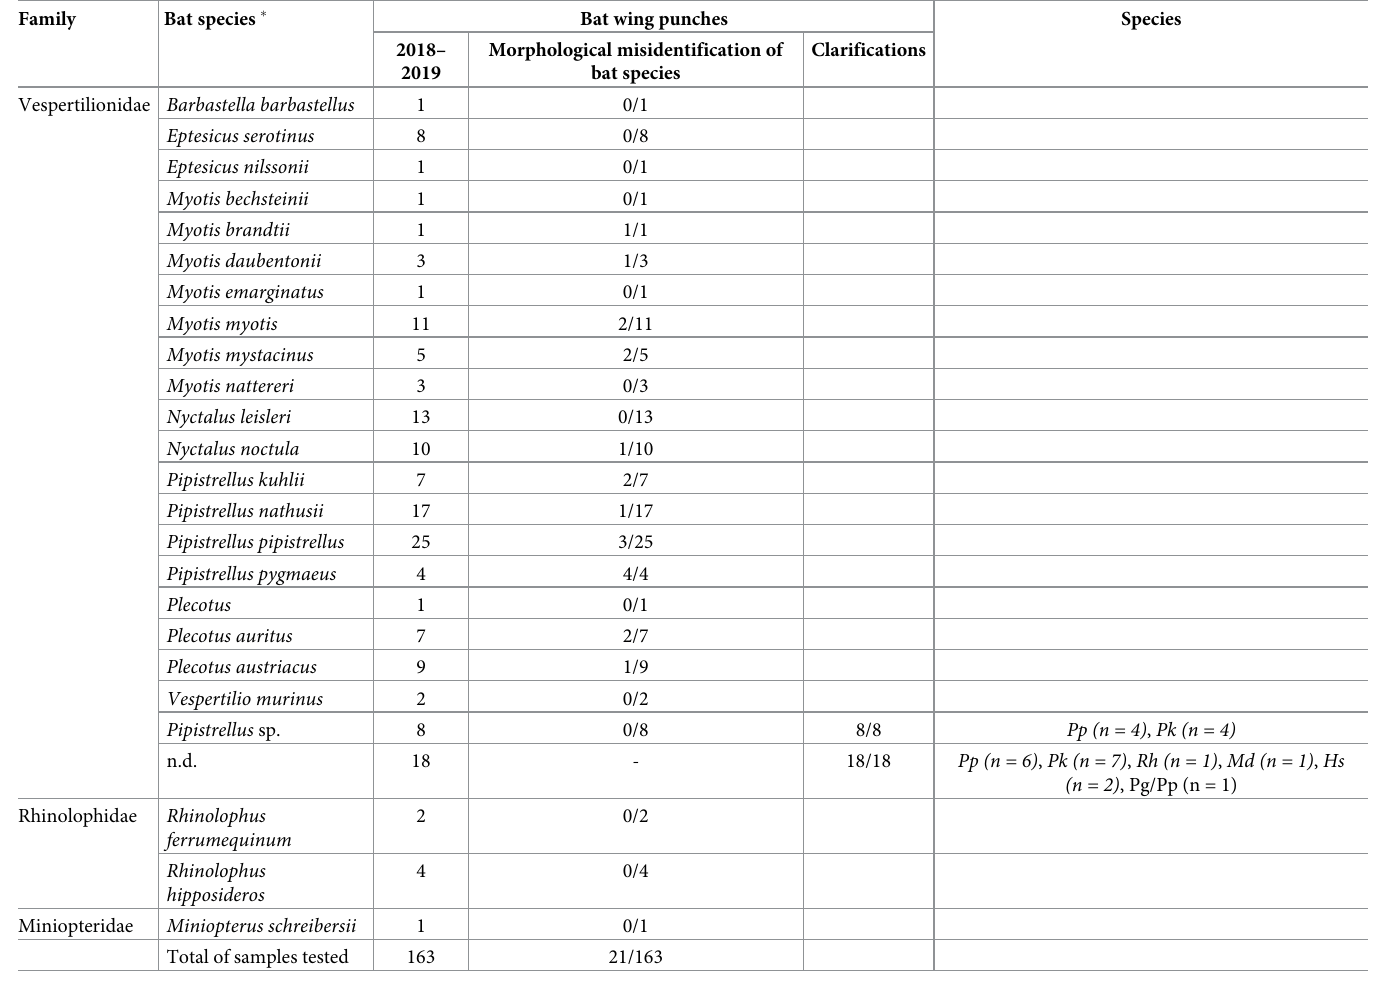
Table 5. Results of PCR on the partial cytochrome b gene and species misidentification of bat wing punch samples compared with morphological species identification.